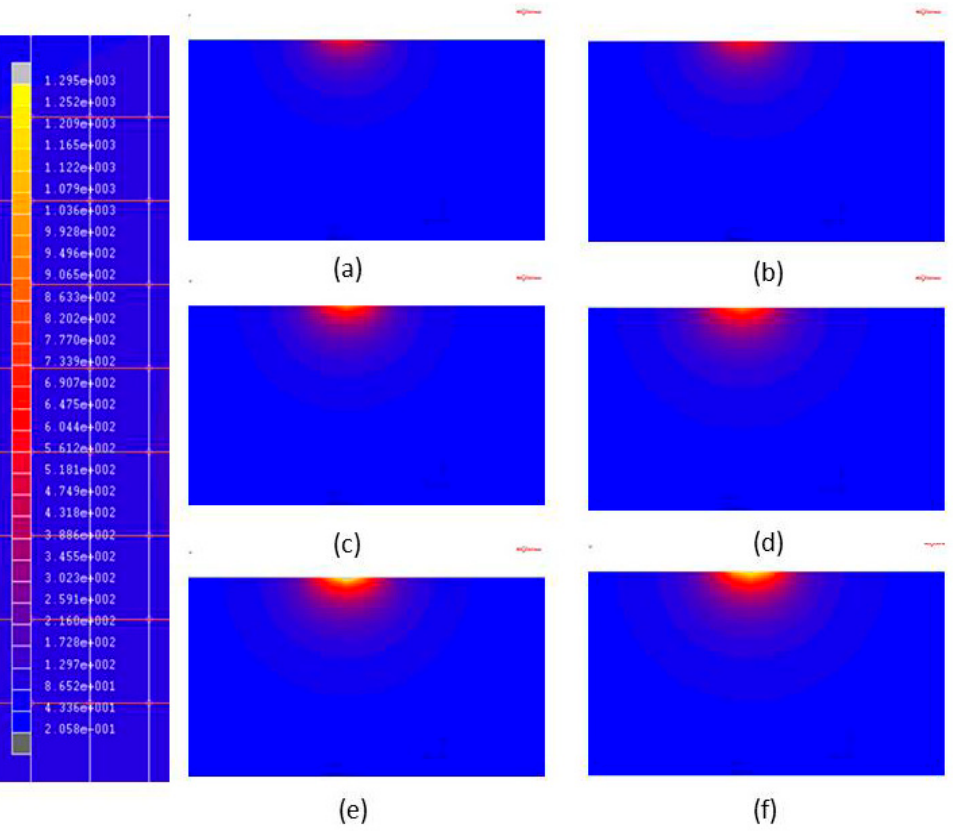
( b ) ( c ) Figure 11. Single-track laser heat treatment. ( a ) Relationship between power and center temperature ( Tc ); ( b ) Relationship between laser power and hardening width; and ( c ) Relationship between hardening depth and laser power.